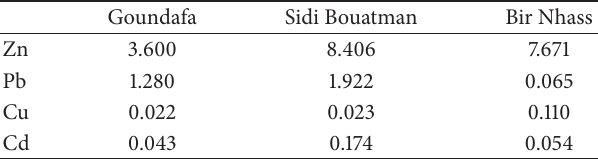
Table 6: Heavy metal concentrations (mg ⋅ mL − 1 ) available in mining residues